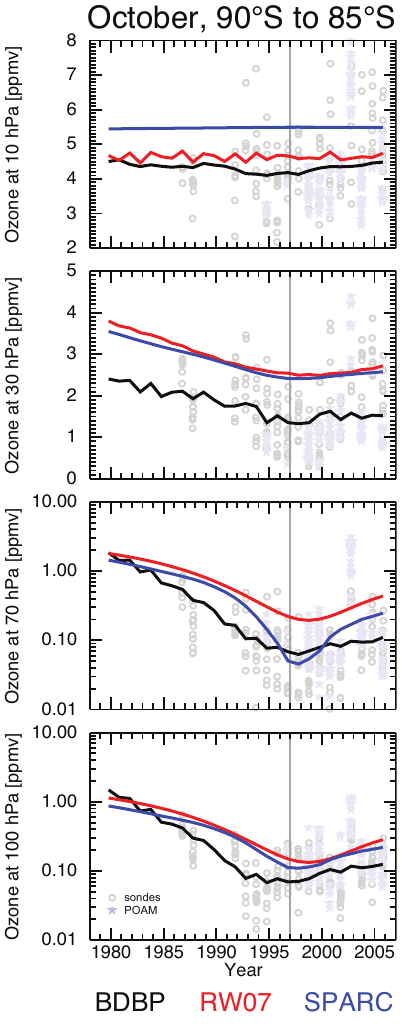
Fig. 7. October ozone time between 85 ◦ S and 90 ◦ S for four dif- Figure 7. October ozone time between 85°S and 90°S for four different pressure levels. 2 ferent pressure levels. Individual ozonesonde (grey open circles), Individual ozonesonde (grey open circles), and POAM II and III (violet starts), and the BDBP 3 and POAM II and III (violet starts), and the BDBP (black), RW07 (red) and SPARC (blue) time series are shown. The vertical grey (Tier 1.4, black), RW07 (red) and SPARC (blue) time series are shown. The vertical grey line 4 line denotes the inflection point selected for piecewise linear trend denotes the inflection point selected for piecewise linear trend calculations. 5